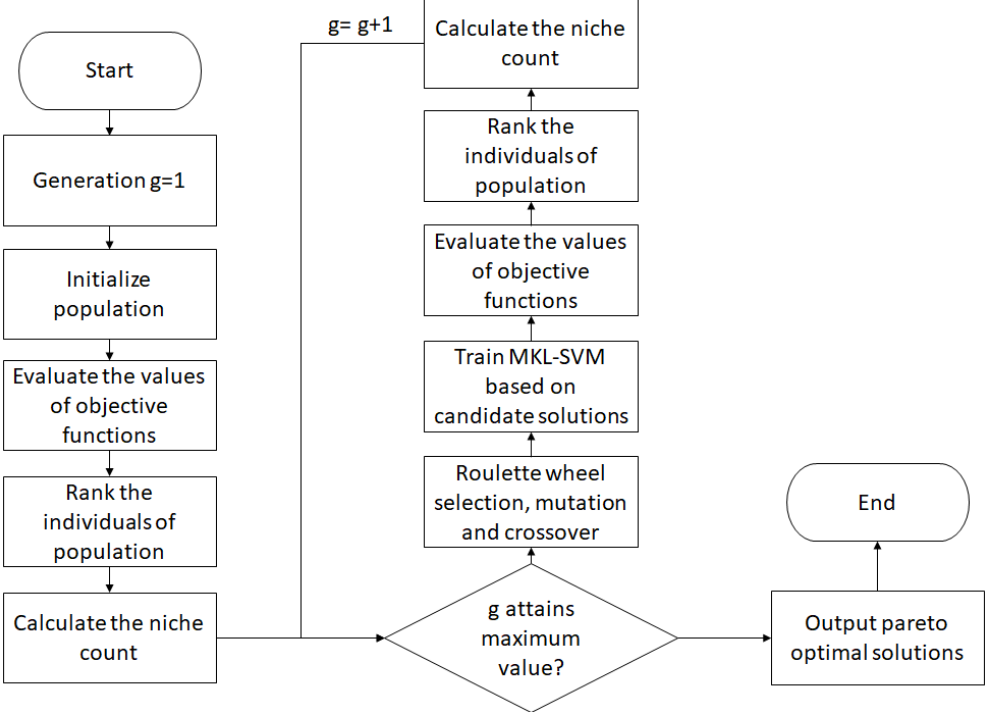
Figure 4. MOGA process for the optimal design of MKL-SVM.